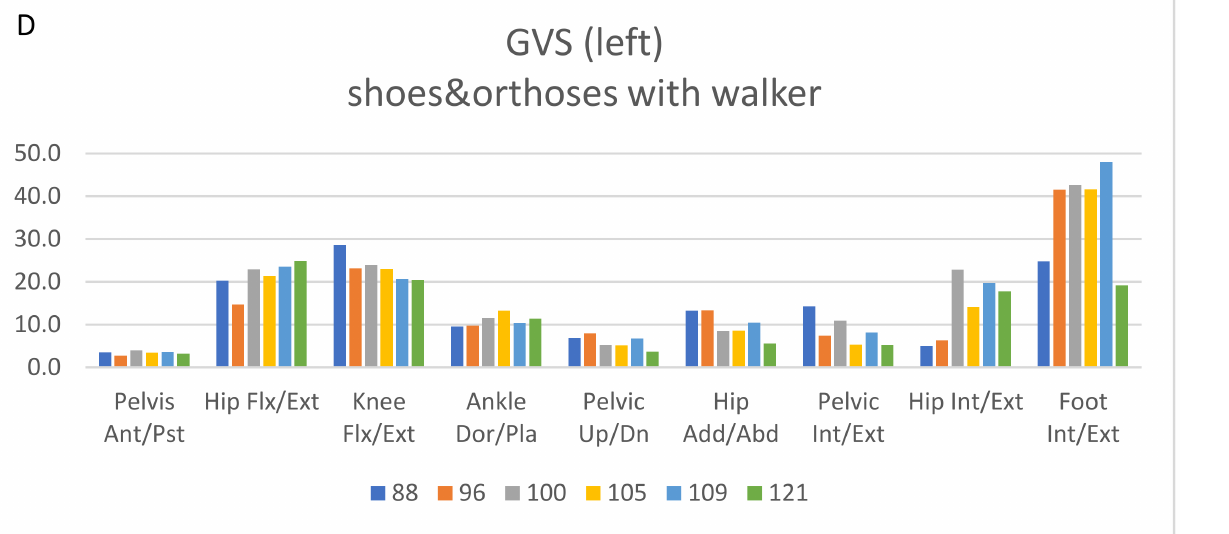
Figure 3. Results from the 3DGA over the follow-up period at 88, 96, 100, 105, 109, and 121 months of age. ( A ): Spatiotemporal parameters (speed and stride length, both normalized to the patient’s height), referring to gait analyses acquired with orthoses and walker. ( B ): Gait profile score (GPS) for the left and right side and overall, referring to gait analyses acquired with orthoses and walker. ( C ): Gait variable score (GVS) for the right side, referring to gait analyses acquired with orthoses and walker. ( D ): Gait variable score (GVS) for the left side, referring to gait analyses acquired with orthoses and